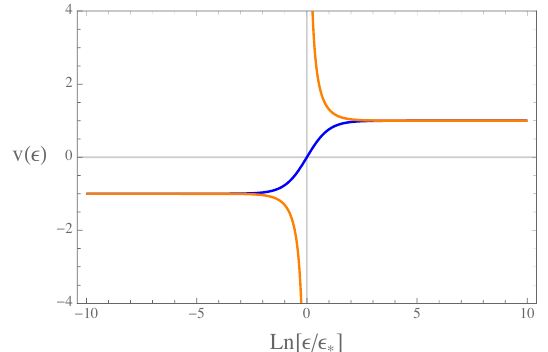
) . An example is shown with both ?